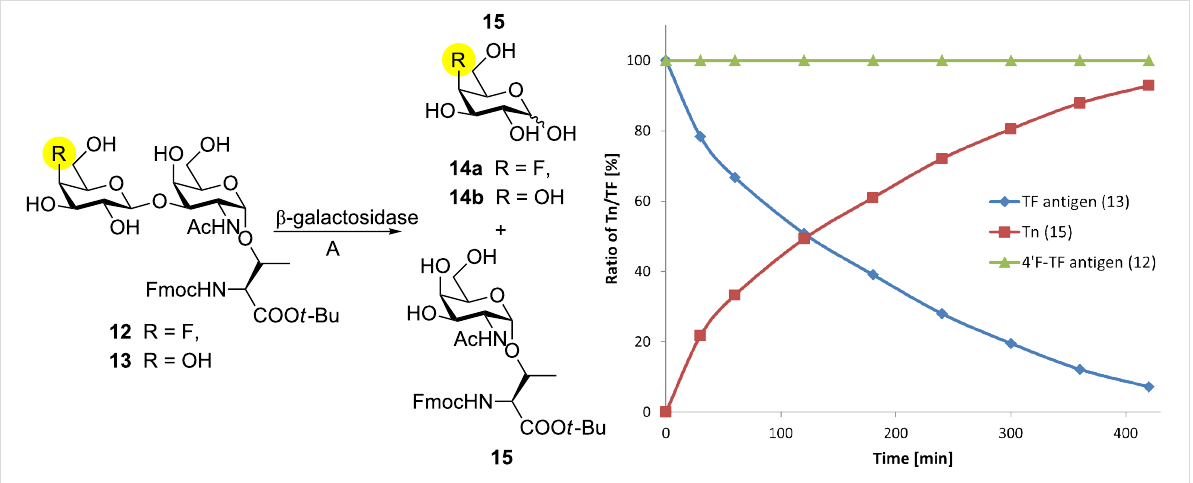
Figure 1: Degradation of 4’F-TF antigen derivative 12 and its natural (synthetic) congener 13 by β -galactosidase from bovine testes. The amounts of intact disaccharide and the evolving degradation product 15 were quantified by HPLC and expressed as a percentage of the corresponding value observed before exposure to enzyme digestion ( t = 0); (A): β -cyclodextrin, MES buffer pH 4.5, 25